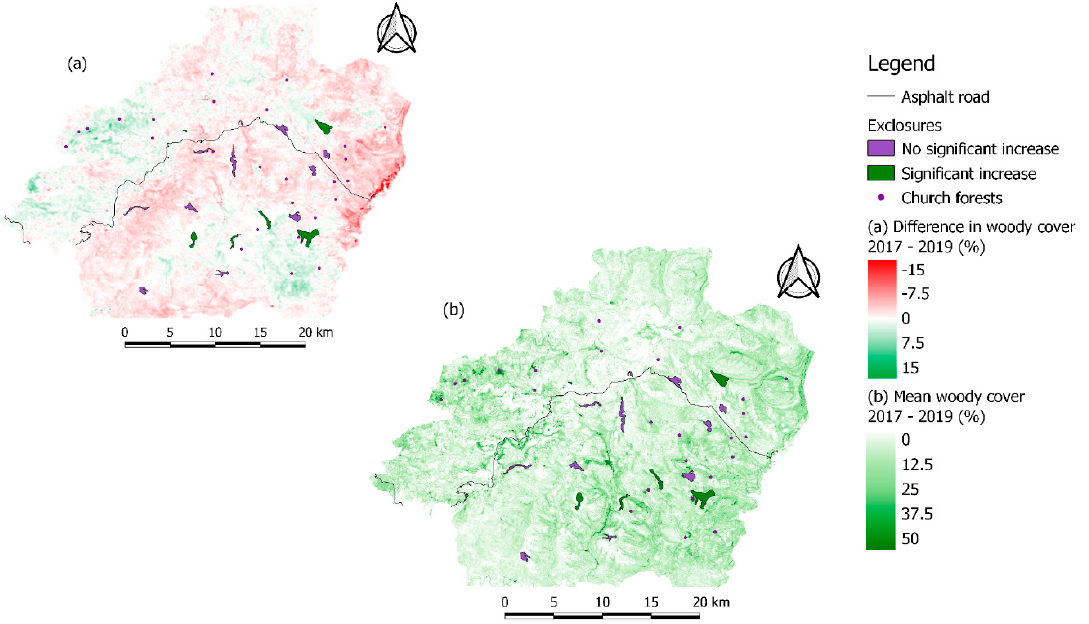
Figure 3. Correlation plot of the characteristics of the 17 exclosures in the Degua Tembien district.